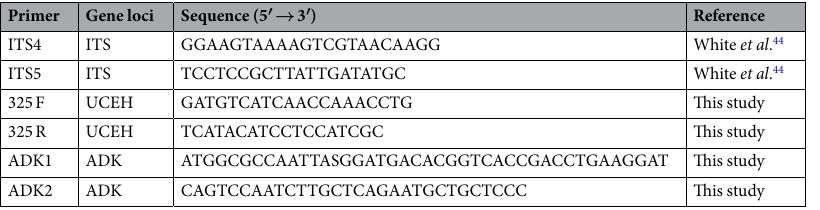
Table 3. Primers used for PCR amplification in this